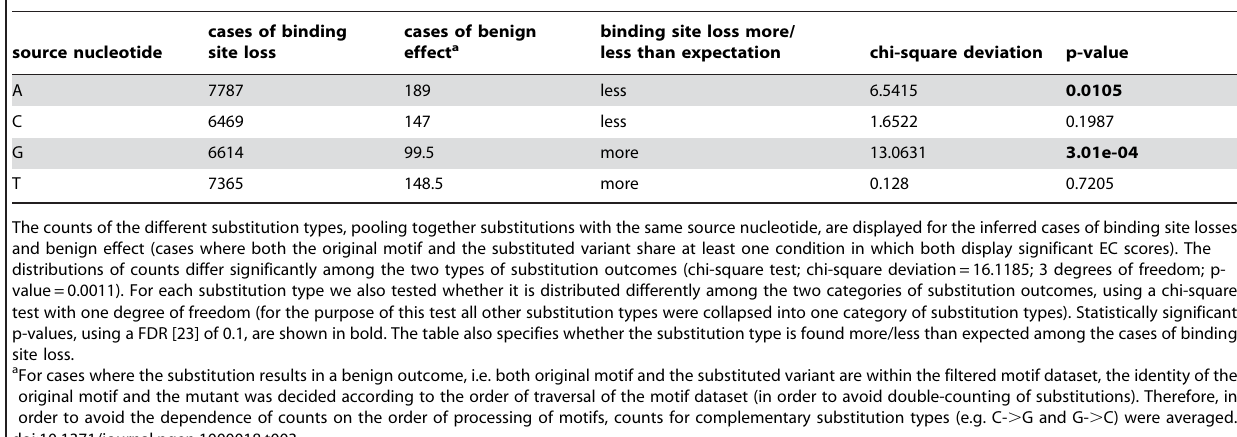
target nucleotide